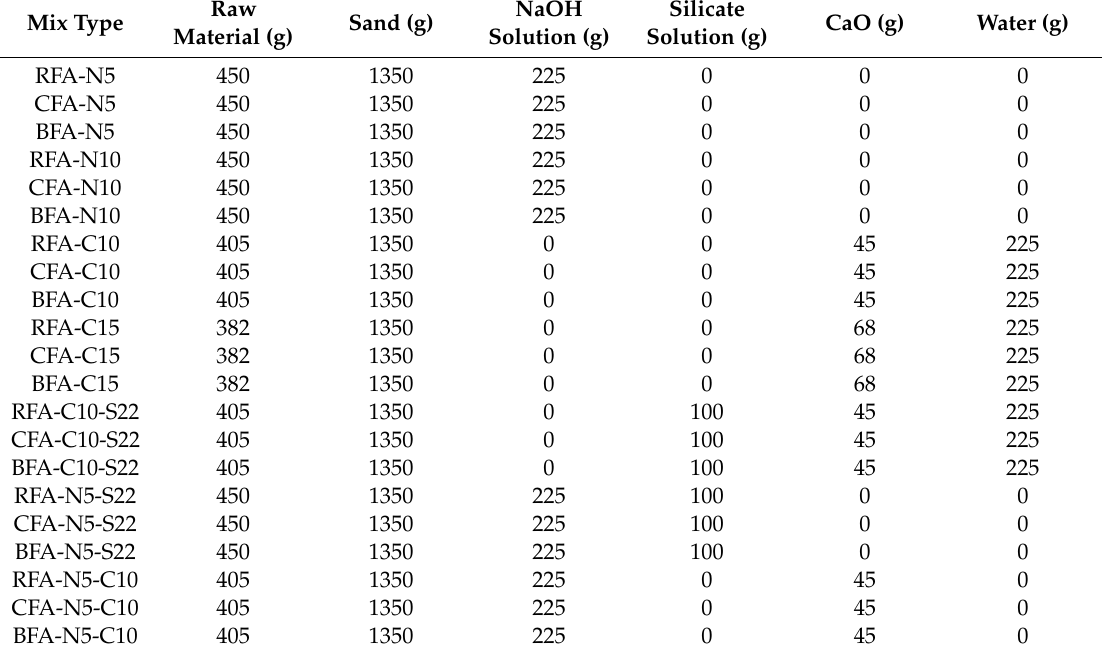
Table 1. Mortar mix